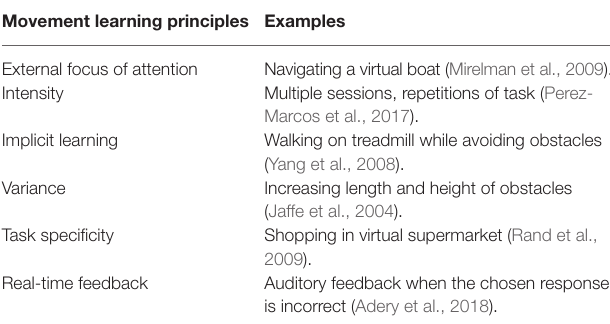
TABLE 1 | Movement learning principles for VR rehabilitation treatment. Movement learning principles Examples External focus of